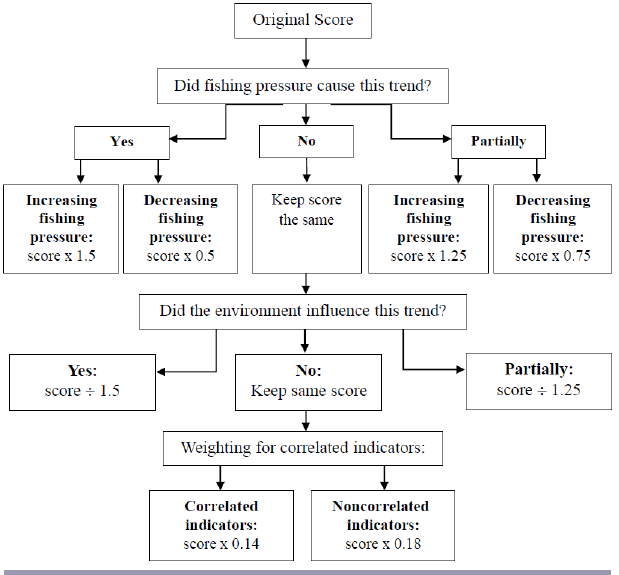
Fig. 2 . Adjustment of original scores attributed to ecological indicators. Original scores were multiplied by the appropriate factor to give a new score, depending on the impact and trend of fishing pressure. The new score was then adjusted again by multiplying by the appropriate factor depending on whether environmental variability could influence this trend to give a final score (adjusted from Lockerbie et al. 2016).